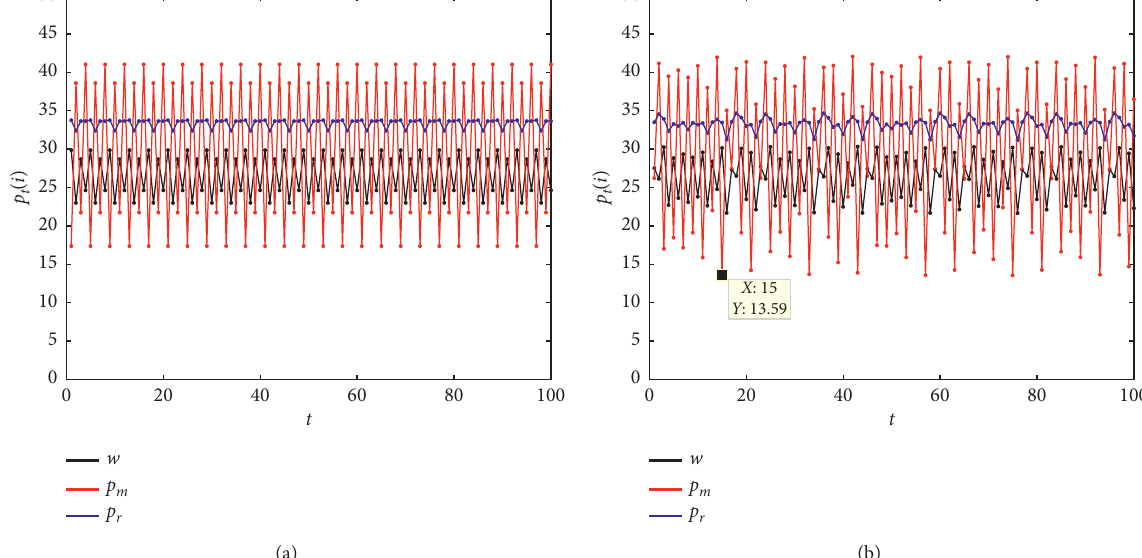
� 0 . 02 , α � 0 . 038. (b) α 1 2